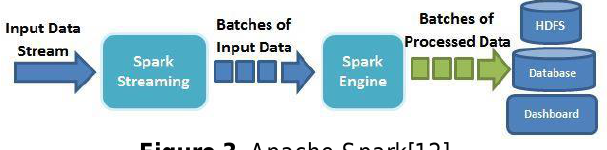
Figure 3. Apache